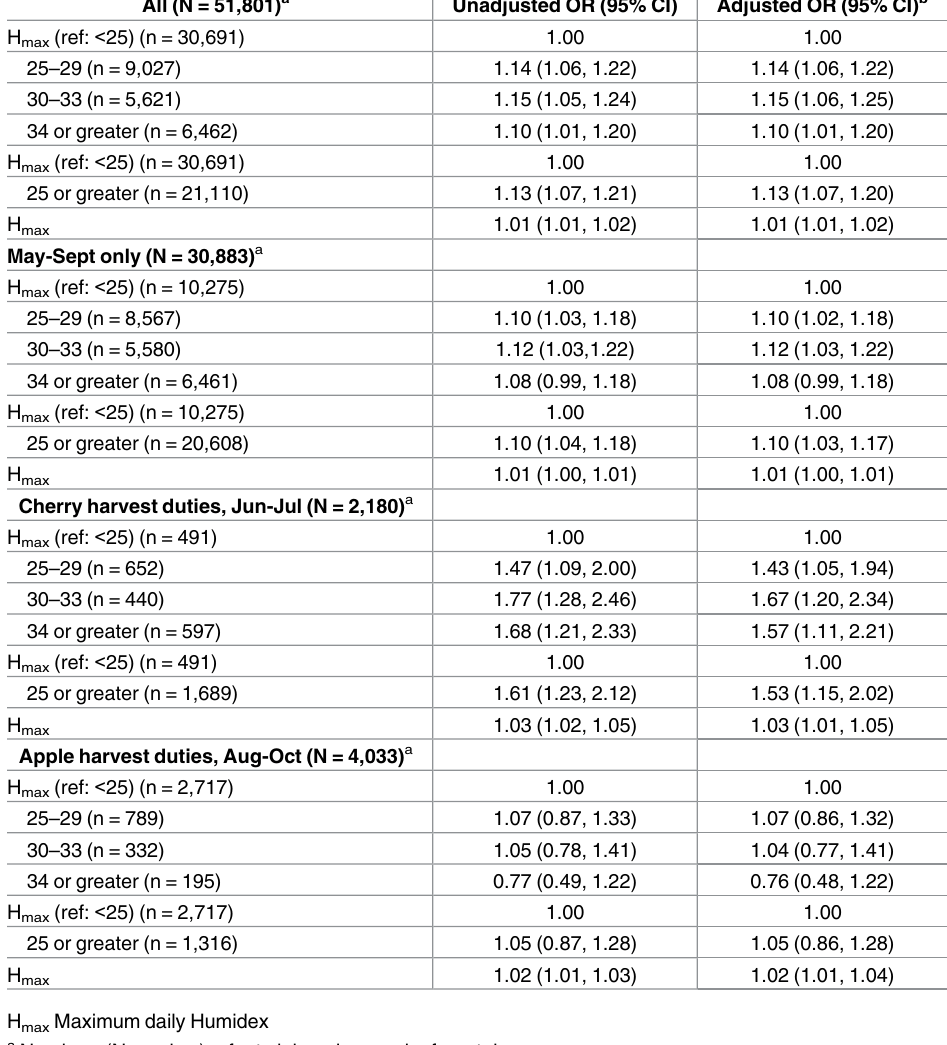
Table 3. Odds ratios (ORs) and 95% confidence intervals (CIs) of workers’ compensation traumatic